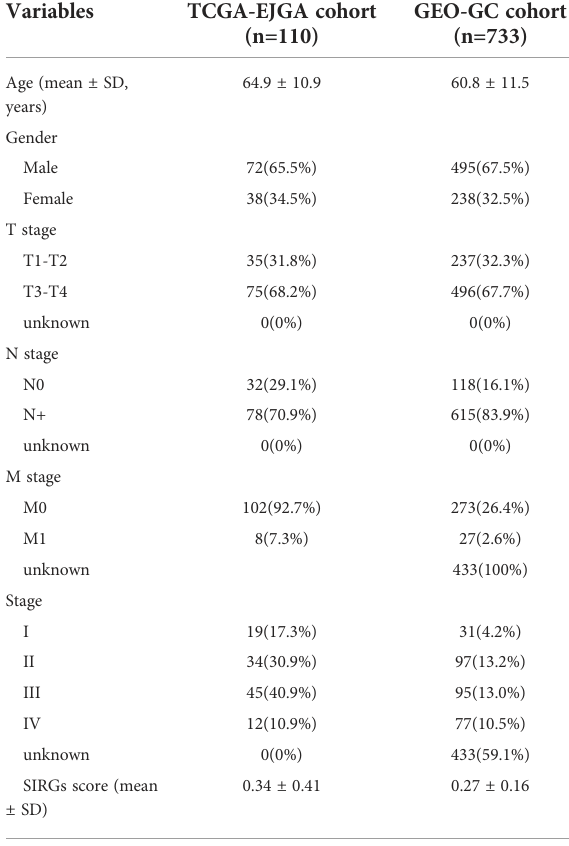
TABLE 1 Clinical characteristics of EGJA and GC